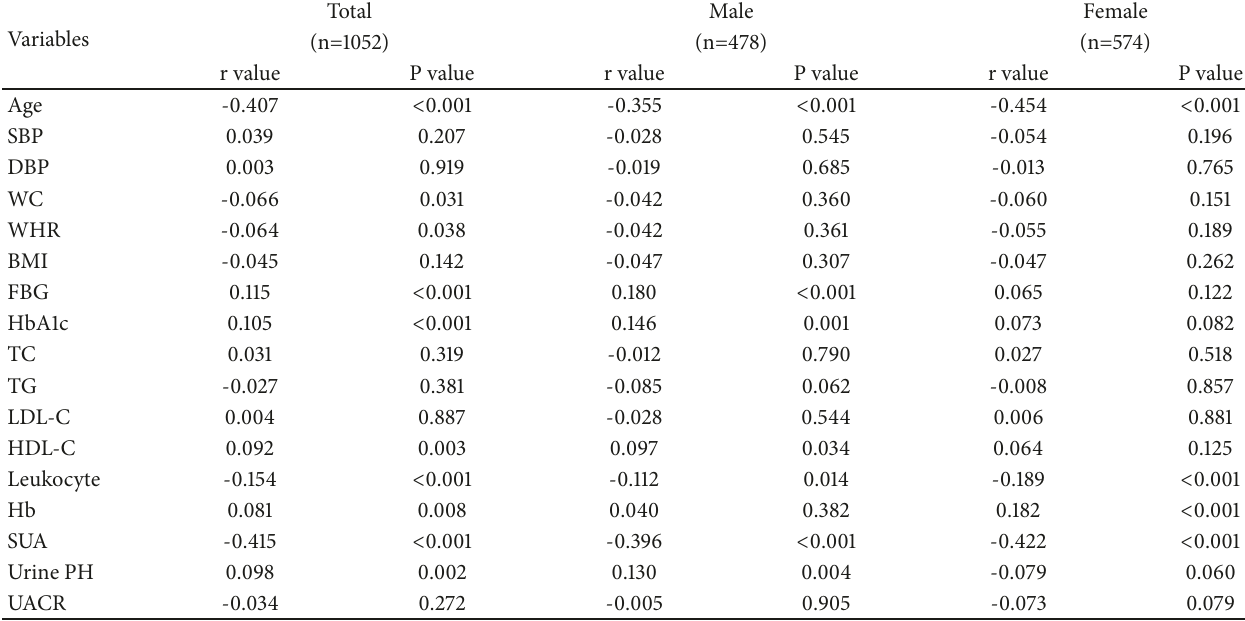
Table 4: Linear correlation between eGFR and parameters including